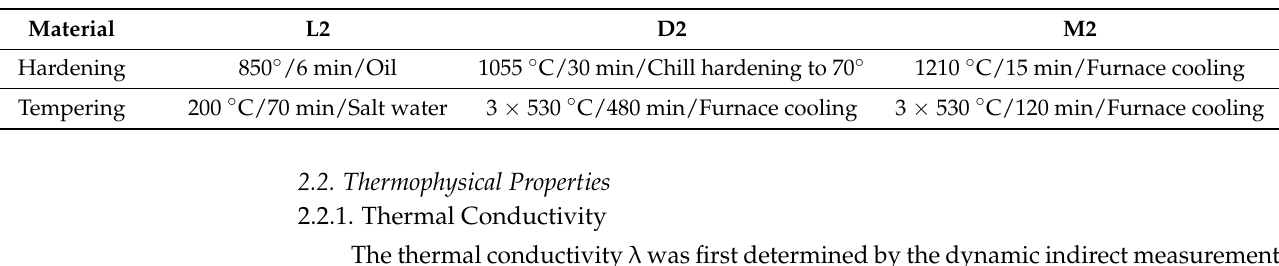
Table 2. Heat treatment of the investigated